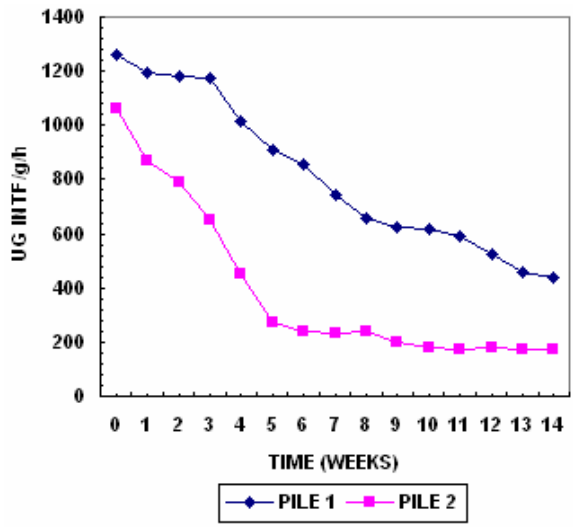
Fig 7: Variation of dehydrogenase activity during composting.